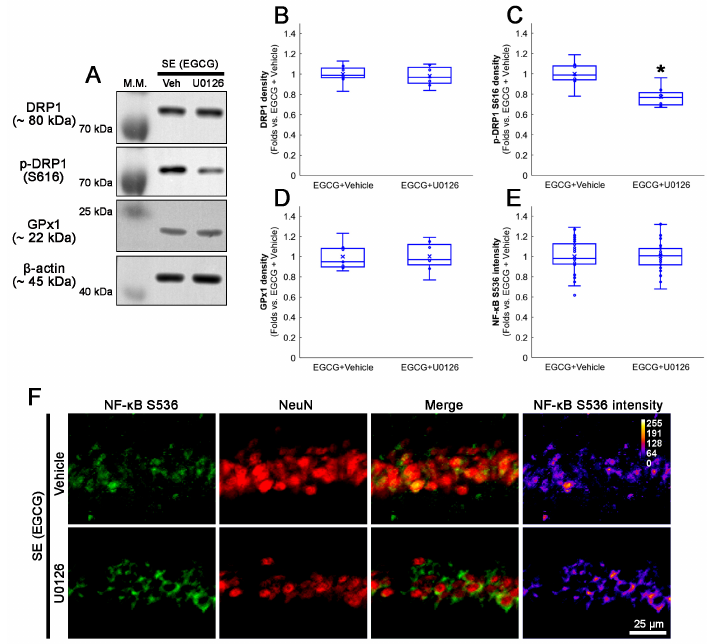
Figure 10. Effects of U0126 co-treatment on DRP1 S616, GPx1 and NF- κ B S536 levels in EGCG-treated